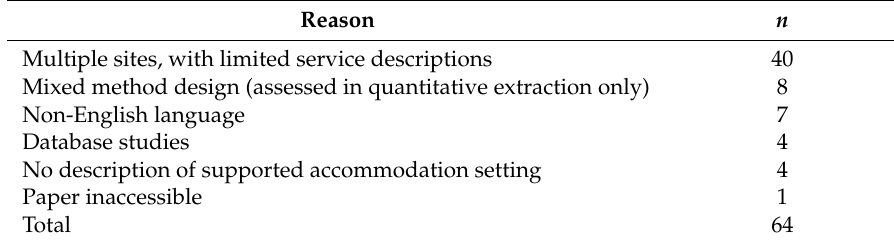
Table 1. Excluded papers.